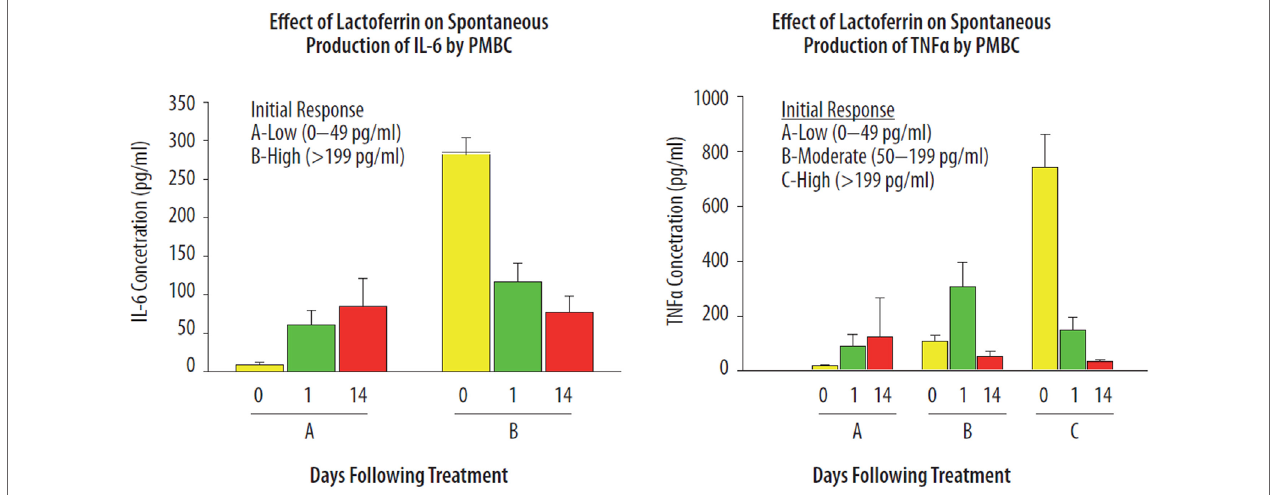
FigURe 4 | Immunoregulatory effects of lactoferrin (LTF) on the spontaneous production of IL-6 and TNF- α from human PMBCs. Healthy volunteers were given one capsule containing 10 mg of LTF, daily for 7 days. Blood samples were examined prior to the first dose, and again 1 and 14 days after administration of the last dose of LTF. The spontaneous production of IL-6 (left) and TNF- α (right) from blood cells was determined by bioassay after 24 h whole blood culture incubation. The data presented have been published previously, in Kruzel et al. (2), reprinted with